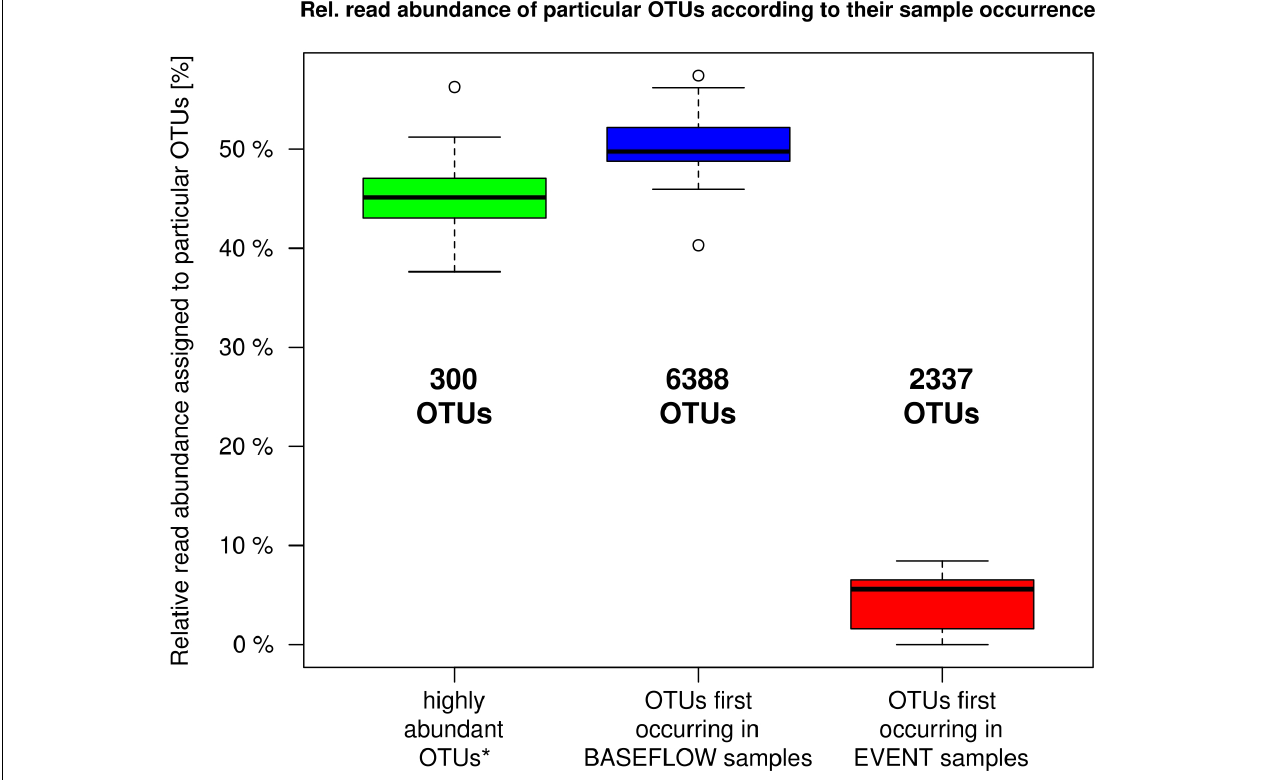
FIGURE 4 | Relative read proportion assigned to OTUs categorized based on their first occurrence in any one sample in chronological order (cf. Supplementary Figure 2 ). Left boxplot: most abundant OTUs that showed > 100 reads per sample and appeared in at least 27 out of 32 samples ( n = 300); Center boxplot: less abundant OTUs that showed their first occurrence in a baseflow-sample (BF01–BF16); Right boxplot: less abundant OTUs that first occurred in an event sample (EV01–EV16).